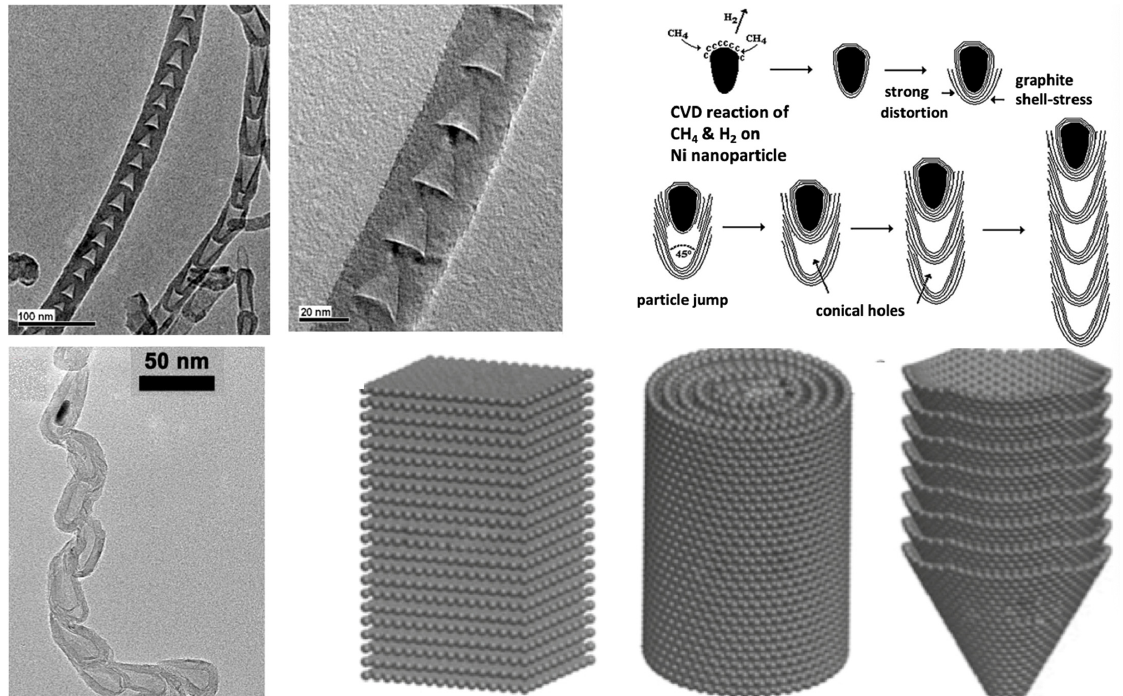
Figure 5. Top row: Conical variations of bamboo carbon nanofibers, and their proposed mechanism of growth, as formed by nickel nucleated CVD using methane and hydrogen. Reproduced open access from Reference [53] Left bottom: Knotty bamboo nanocarbon variations by CVD, and their proposed mechanism of growth. Modified from Reference [58] Right bottom: General graphene layer conformations occurring in carbon nanofibers. Modified from Reference